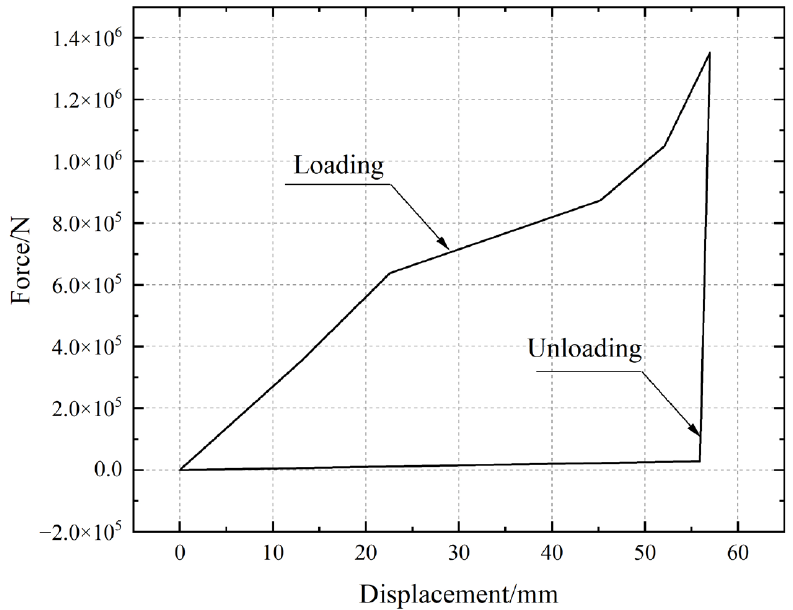
Figure 6. The force-displacement curve of MT-2.